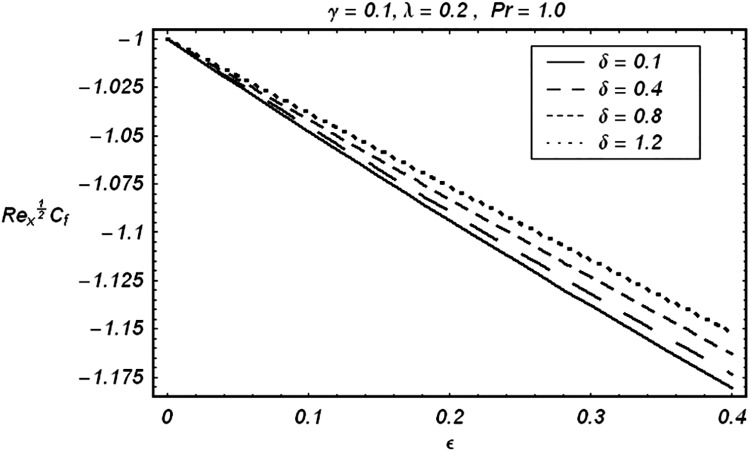
Effect of δ on skin friction.